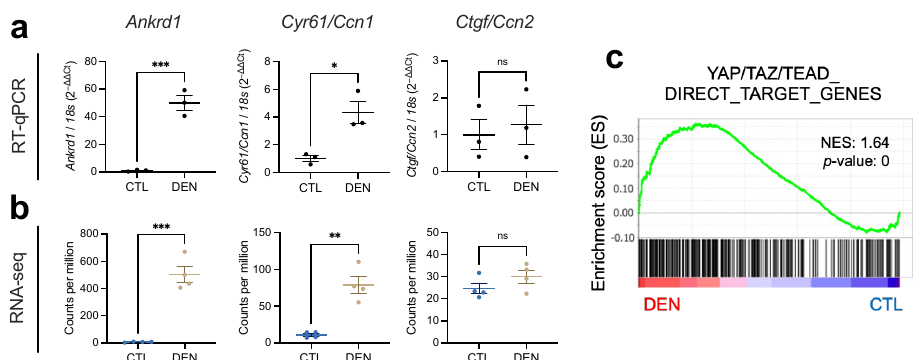
Figure 3. YAP/TAZ/TEAD transcriptional activity is increased in denervated skeletal muscles. ( a ) RT-qPCR analysis of Ankrd1 , Cyr61/Ccn1 , and Ctgf/Ccn2 expression in DEN and CTL (14 days) soleus muscles. N = 3 independent mice. * = p < 0.05, *** = p < 0.001, ns = not significant; unpaired t test. ( b ) RNA-seq analysis (counts per million of mapped reads) of Ankrd1 , Cyr61/Ccn1 , and Ctgf/Ccn2 expressions from DEN and CTL GST muscles. N = 4 independent mice. ** = p < 0.01, *** = p < 0.001, ns = not significant; unpaired t test. ( c ) Gene set enrichment analysis of YAP/TAZ/TEAD direct target genes in DEN and CTL GST muscles. NES = normalized enrichment